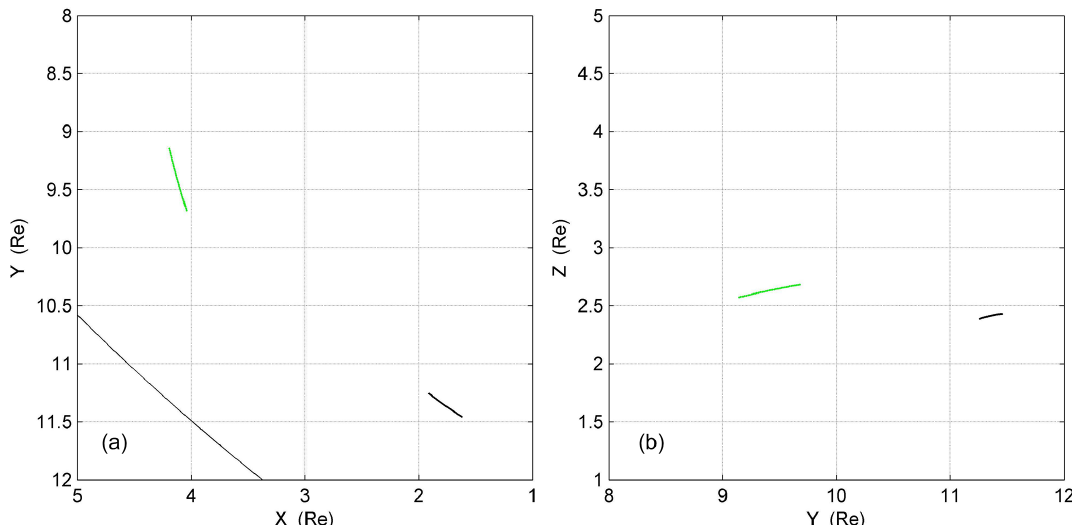
Figure 1. The orbits and positions of TH-A (green) and TH-E (black) during the interval of interest 22:20–22:54UT. The position data are expressed in GSM